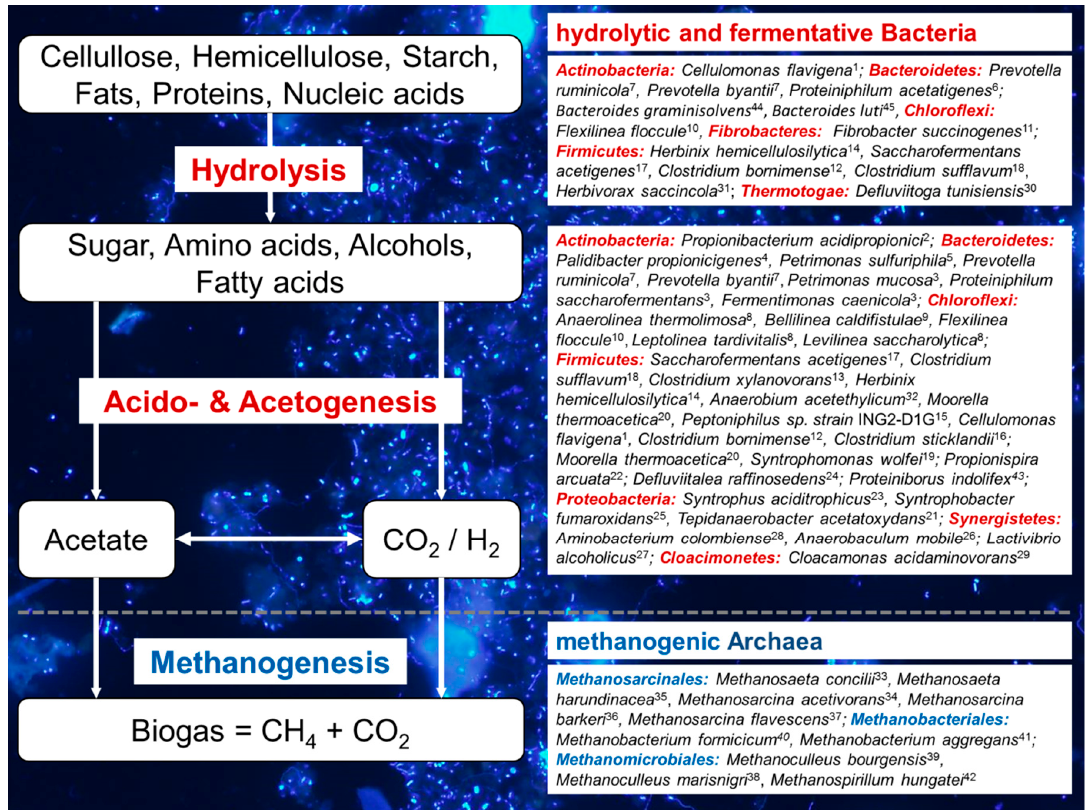
Figure 1. Compilation of the currently physiologically and/or genetically described microorganisms putatively involved in the different steps of the anaerobic digestion process. The corresponding reference list is given in Supplement 1. The microscopic image in the background shows a biogas microbiome stained with DAPI (4 ′ ,6-diamidino-2-phenylindole) of an anaerobic digester treating a mixture of energy crops and animal manure (photo by J. Klang). CO 2 = carbon dioxide, H 2 = hydrogen, CH 4 = methane.